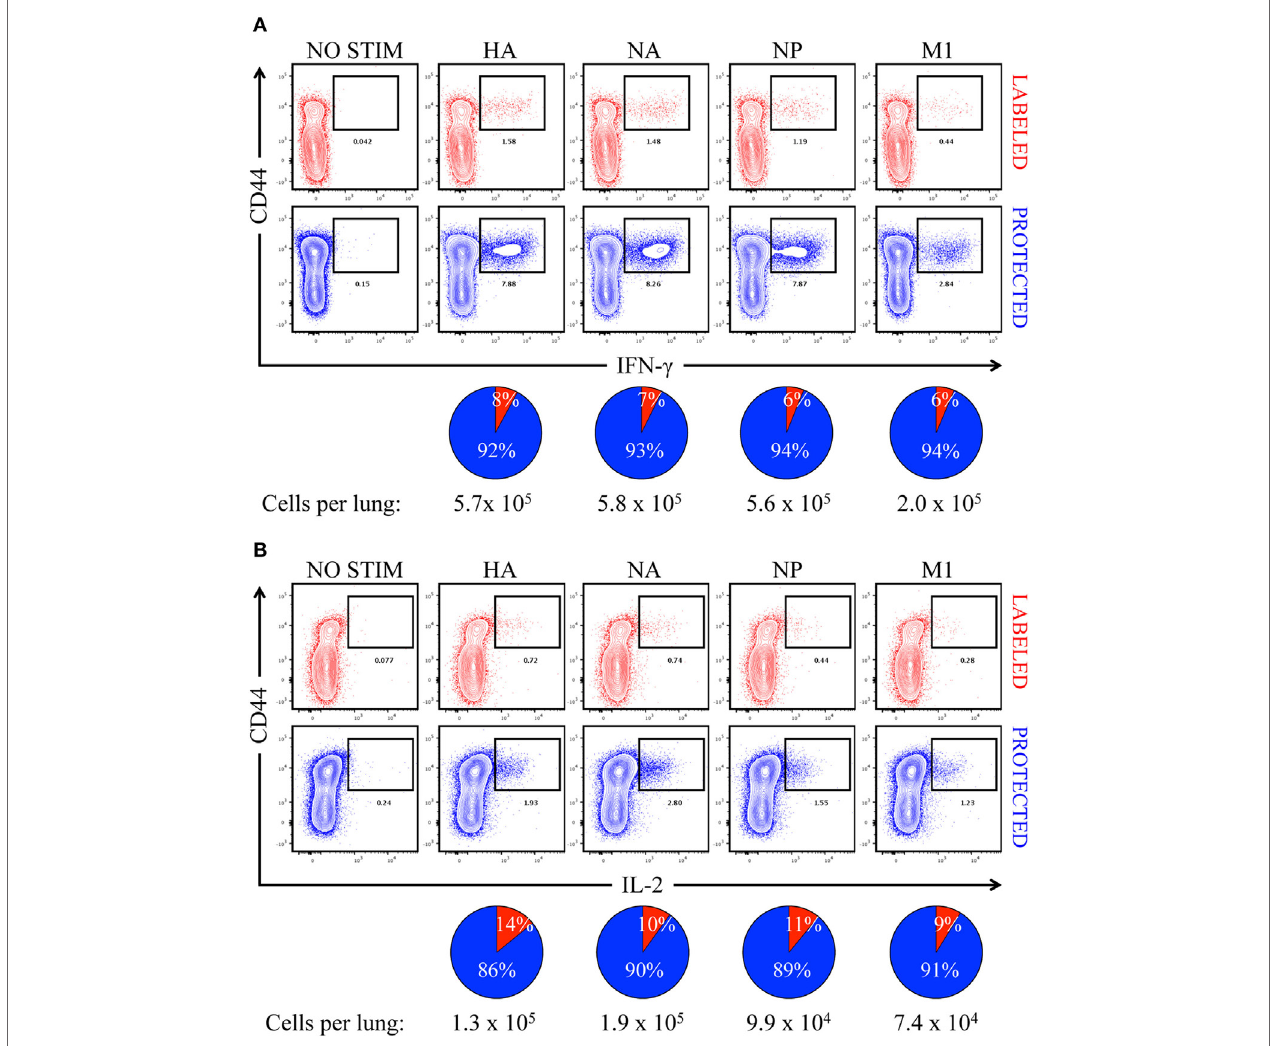
FigUre 6 | Virus-specific, cytokine-producing CD4 T cells are enriched in “protected” niches in the lung following influenza virus infection. Contour plots illustrating antigen-specific reactivity to HA, NA, NP, and M1 proteins by intravenously (IV) “labeled” (red) and “protected” (blue) pulmonary CD44 hi CD4 T cells, as measured by (a) IFN- γ and (b) IL-2 production. Pools of peptides from each of four different viral proteins, indicated above each panel, were used for stimulation. The pie charts below each cytokine set reflect the fraction of cytokine-producing CD4 T cells in pulmonary vasculature vs . tissue (vasculature in red and tissue in blue), with the total number of responding cells indicated. The responses shown are from pooled samples from five